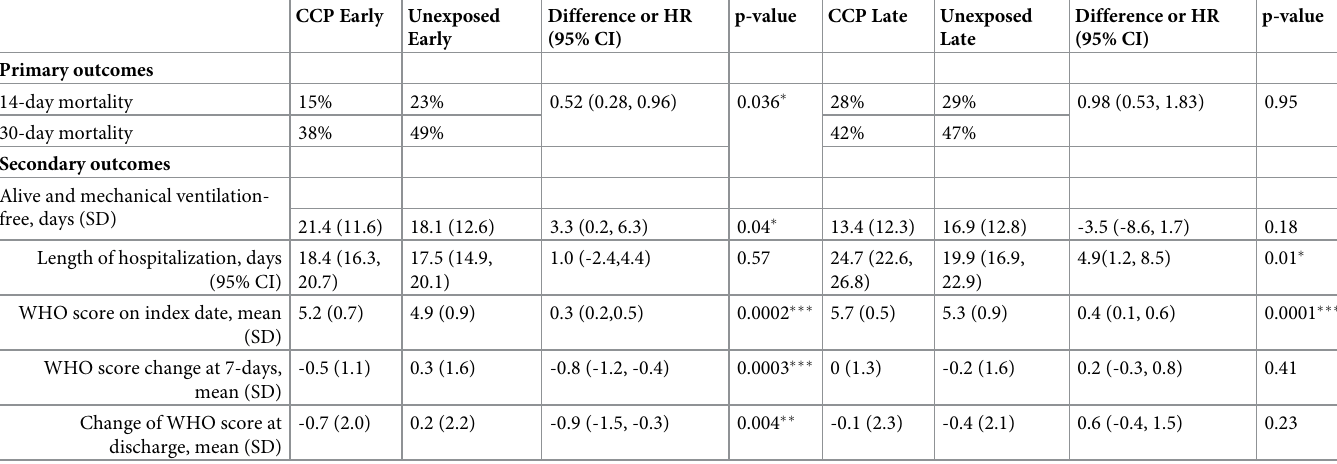
Table 2. Primary and secondary study